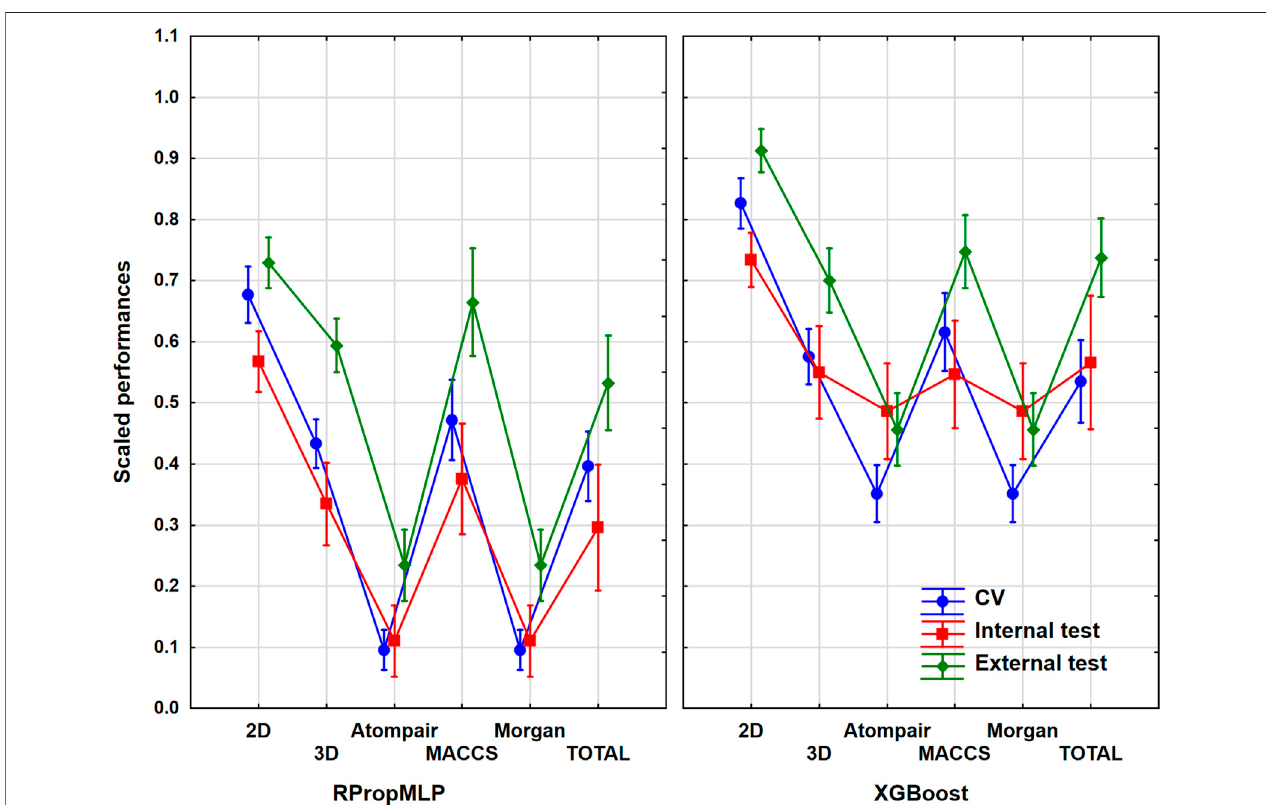
FIGURE 4 | Scaled performances of the models in case of the hepatotoxicity dataset based on the molecular descriptor types and machine learning algorithms. The 18 performance parameters were range-scaled between 0 and 1 and averaged across all models with the given descriptor types/ML algorithms. The result of CV is markedwithblue,theinternaltestresultismarkedwithred,andtheexternaltestismarkedwithgreen.Themeanofthescaledperformanceparametersisplottedineach case with the 95% con fi dence intervals.